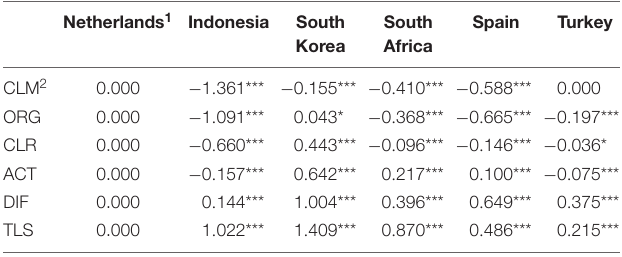
TABLE 8 | Comparison of latent means of the scalar invariance Multi-Group Confirmatory Factor Analysis (MGCFA) model.